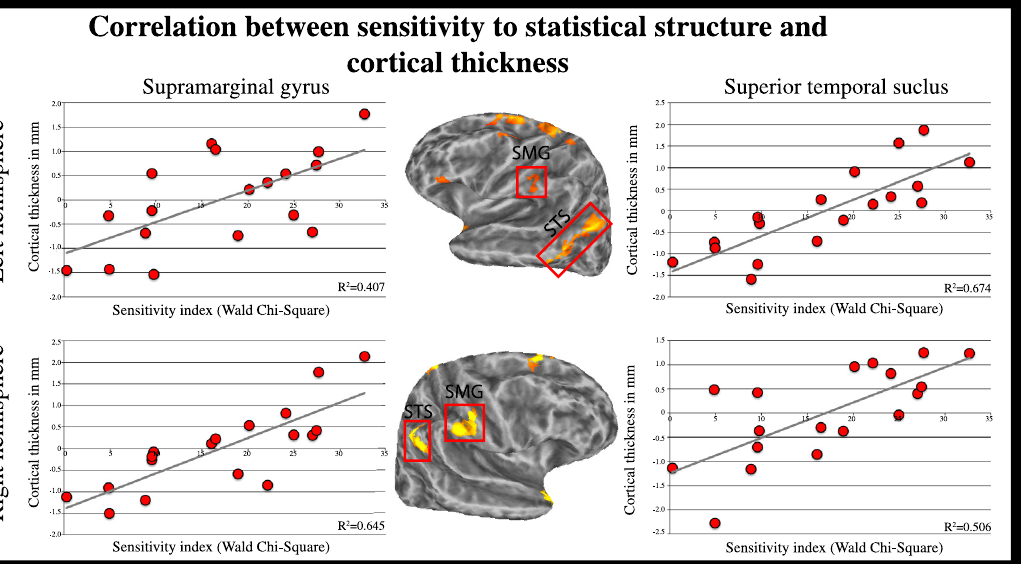
Fig 4. Scatter plot illustrating the relationship between CT and sensitivity to regularity with age regressed out (the values plotted are the resulting z-transformed residuals). SMG = supramarginal gyrus; STS = superior temporal sulcus.